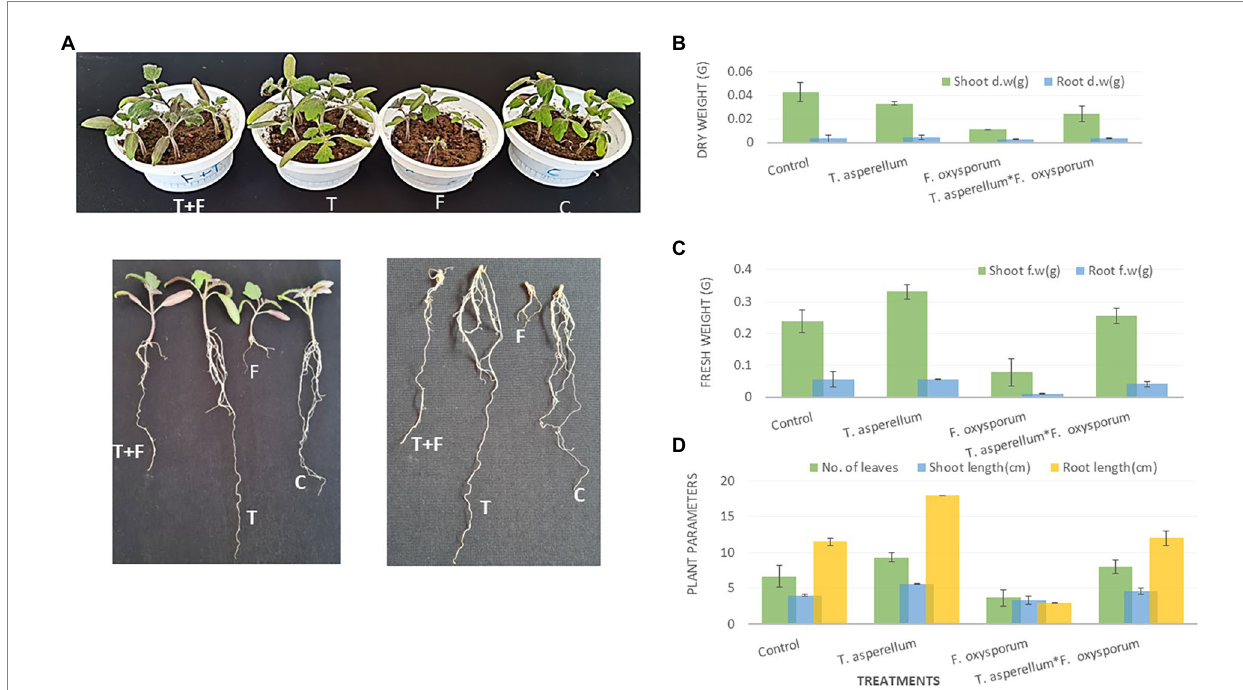
FIGURE 6 The Effect of T. asperellum on the growth of tomato plants under biotic stress of F. oxysporum including (A) ; T- Trichoderma enhances both root and shoot of tomato seedlings, F- Fusarium can penetrate tomato roots and cause wilting or root rotting diseases, T + F-the interaction between the fungal